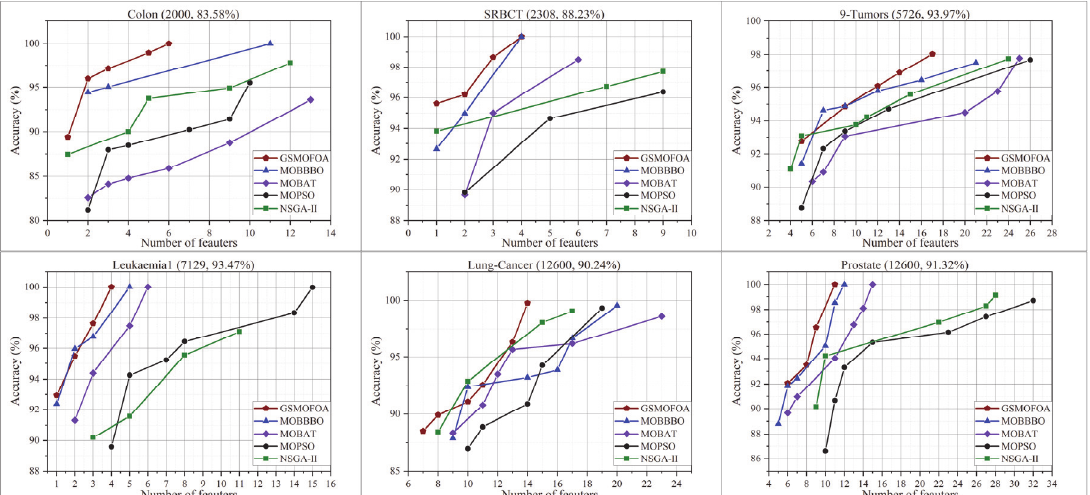
Fig. 5. Comparison of GSMOFOA ND solutions with other multi-objective algorithms on the test set